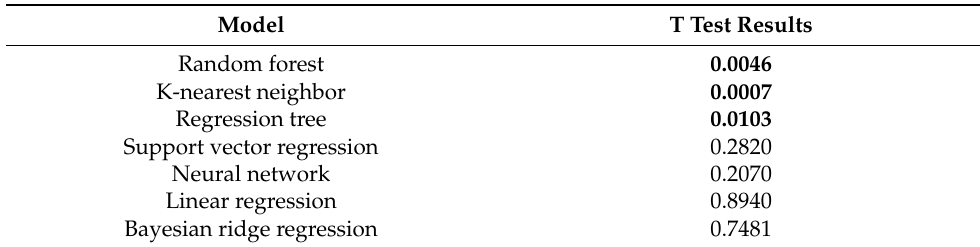
day, the number of days since the sown date, total solar radiation, and the total rainfall. Significant Table 7. Results from ReliefF feature selection. The average scores from using the features number results are shown in bold. of days since the sown date, total rainfall, and the average minimum temperature since the previ-